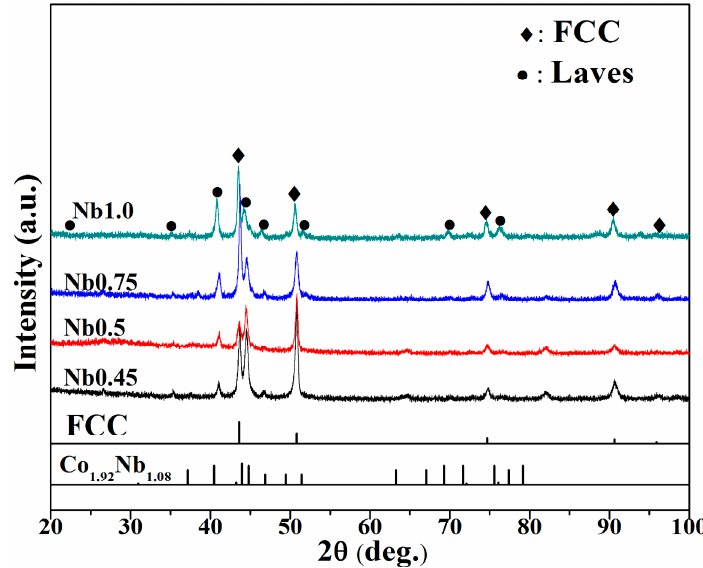
Figure 1. X ‐ ray diffractometer patterns of the CoCrFeNiNb x high entropy alloys (HEA) coatings. Figure 1. X-ray diffractometer patterns of the CoCrFeNiNb x high entropy alloys (HEA)